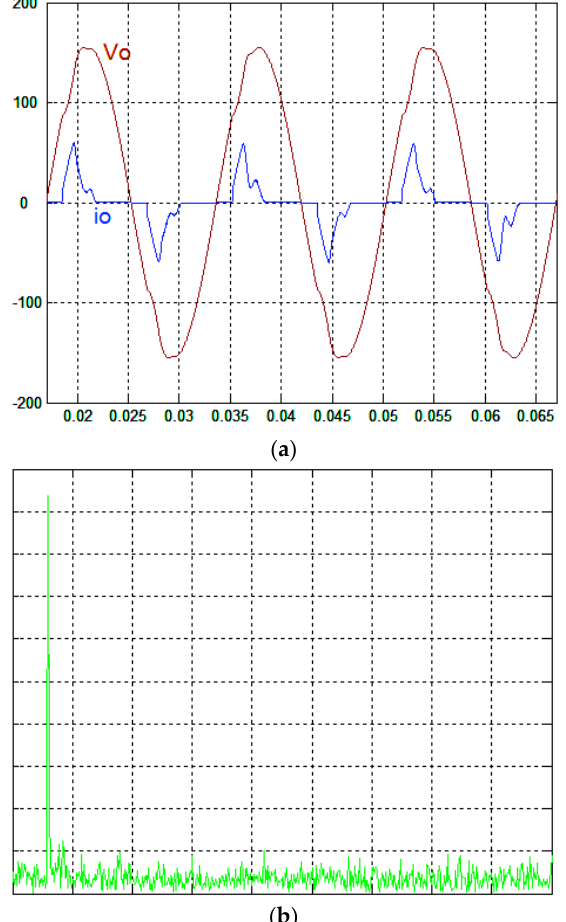
Figure 5. ( a ) Simulation waveforms of the output voltage and output current under nonlinear load for the classical finite ‐ time convergent SMGL (100 V/div; 20 A/div); ( b ) Harmonic spectrum of output voltage.